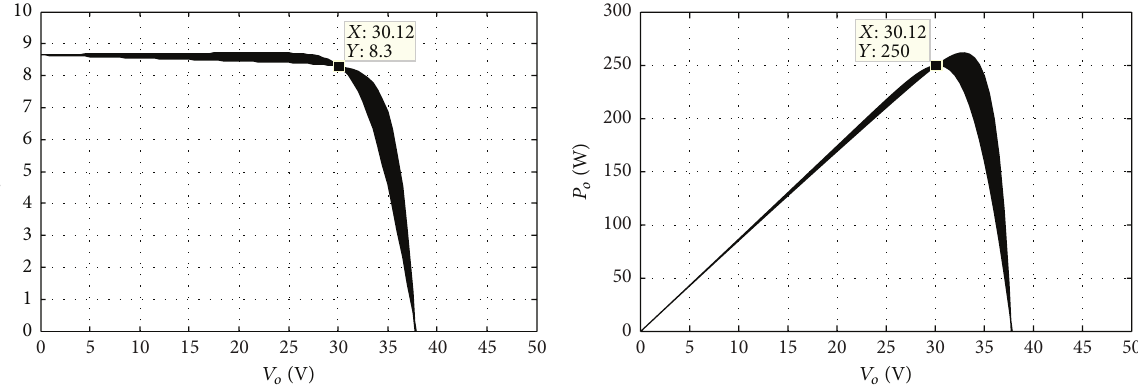
Figure 6: MATLAB iteration result to calculate 𝑅 𝑠 and 𝑅 𝑝 .